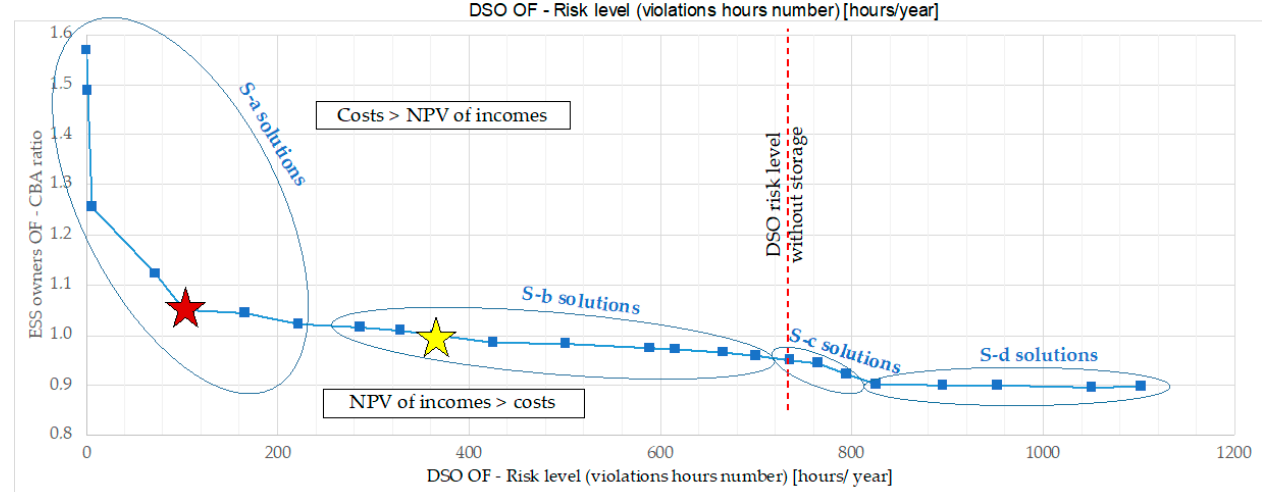
Figure 9. Case study: Pareto optimal front.